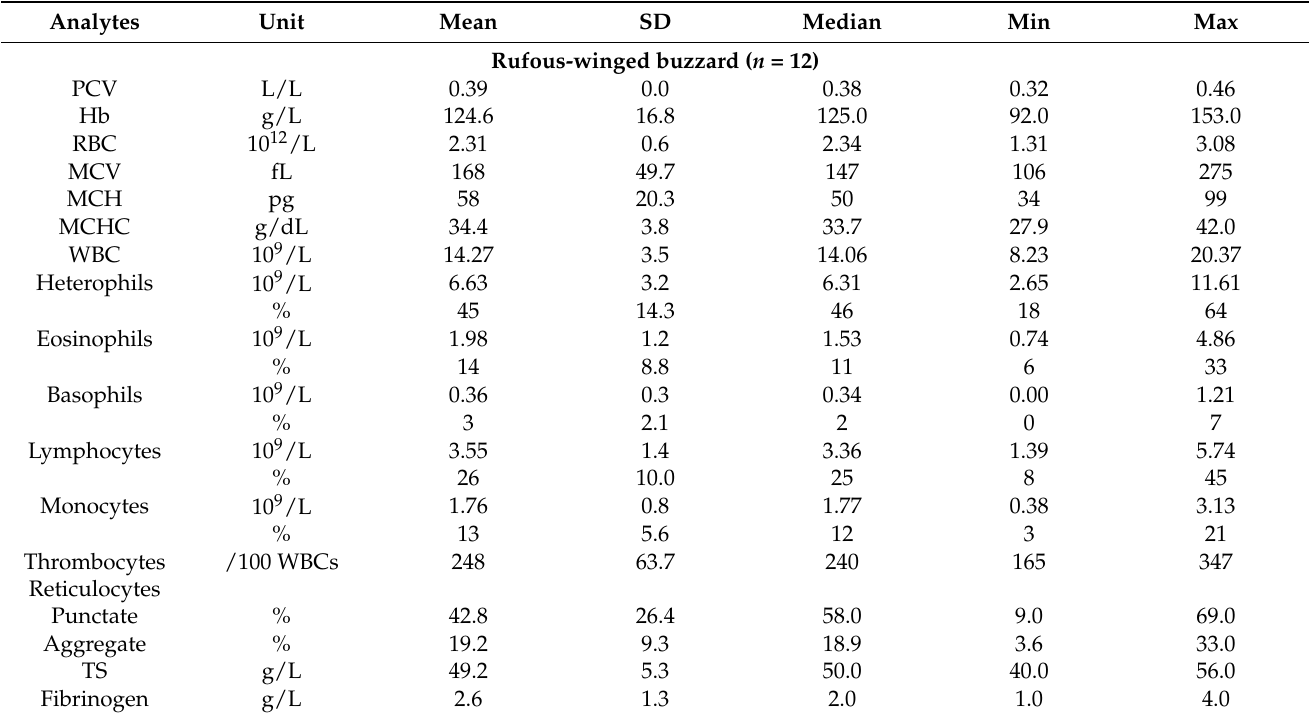
Table 2. Descriptive summary of hematologic values of rufous-winged buzzards of both sexes and different ages.